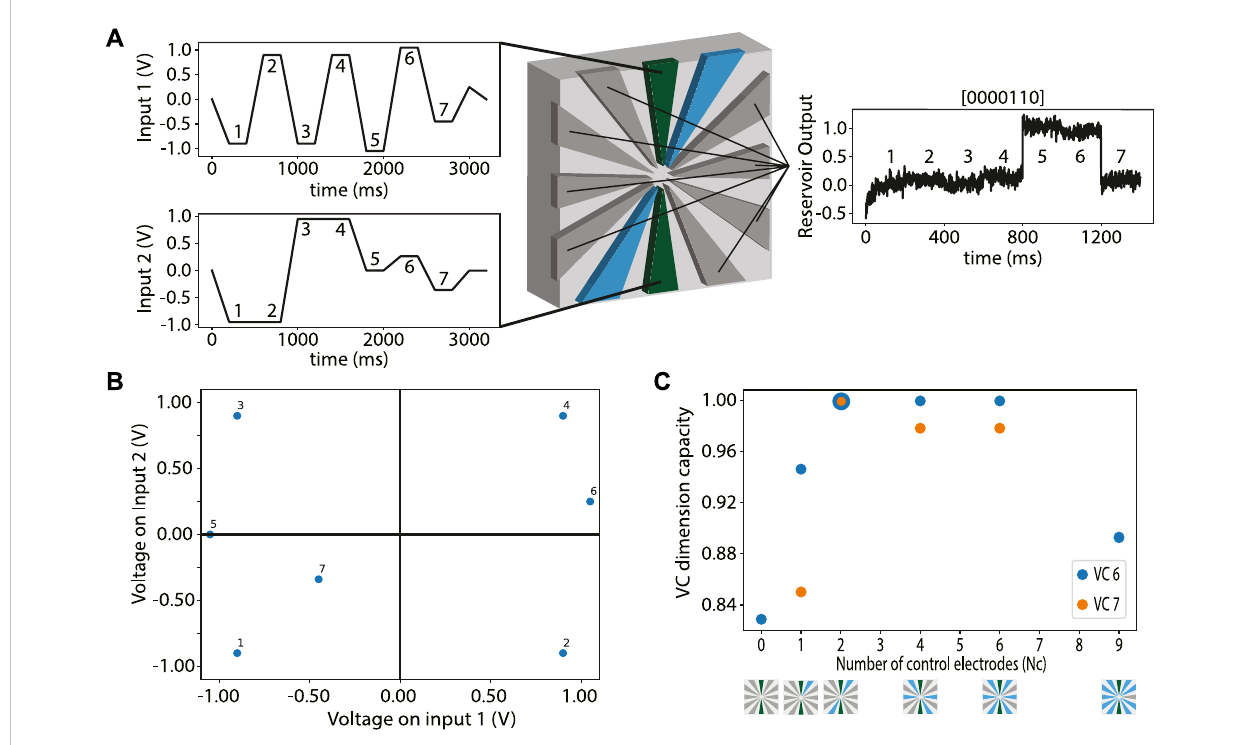
FIGURE 2 VC dimension analysis: (A) Schematic of the VC dimension benchmark for the raw input waveforms on the left using the DNPU (inputs: green, controls: blue, outputs: grey) and the readout layer in a tuneable ELM operation mode, with N C = 2 control electrodes and N O = 8 output electrodes (middle). The output waveform of label [0000110] for VC dimension seven is displayed on the right, where only the output at the plateaus of the input is shown. (B) Schematic of the seven voltage input points labelled one to seven to indicate which points are used for the analysis of the VC dimension 1 – 7. (C) The capacity (fraction of correct labels) for the different operation modes, indicated by the number of control electrodes used. Blue: VC dimension 6 (6 input points). Orange: VC dimension 7 (7 input points, only for the tuneable ELM modes). The DNPU schematics at the x-axis show the electrode con fi